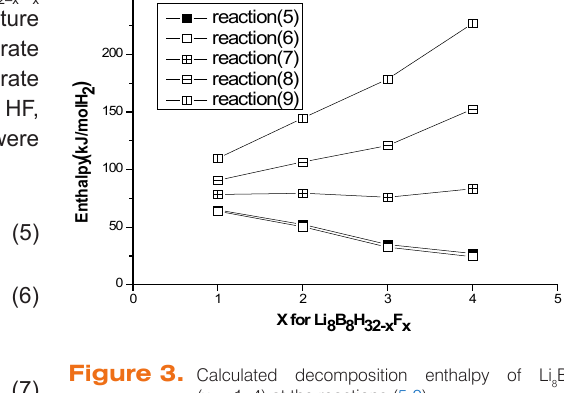
(x = 1–4) at the reactions